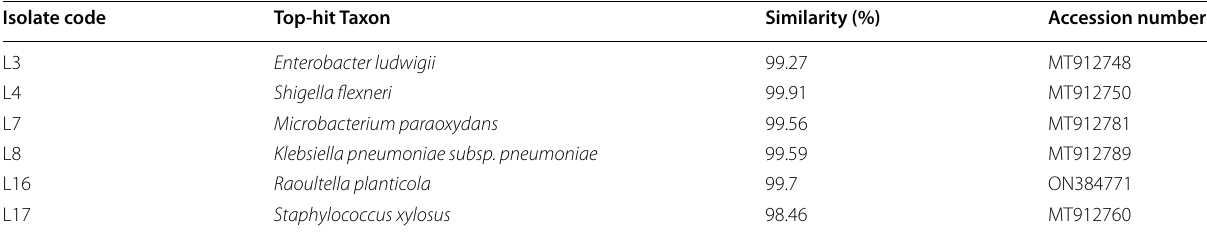
Table 1 Top-hit taxon, similarity percentage and accession numbers of the selected bacterial isolates Isolate code Top-hit